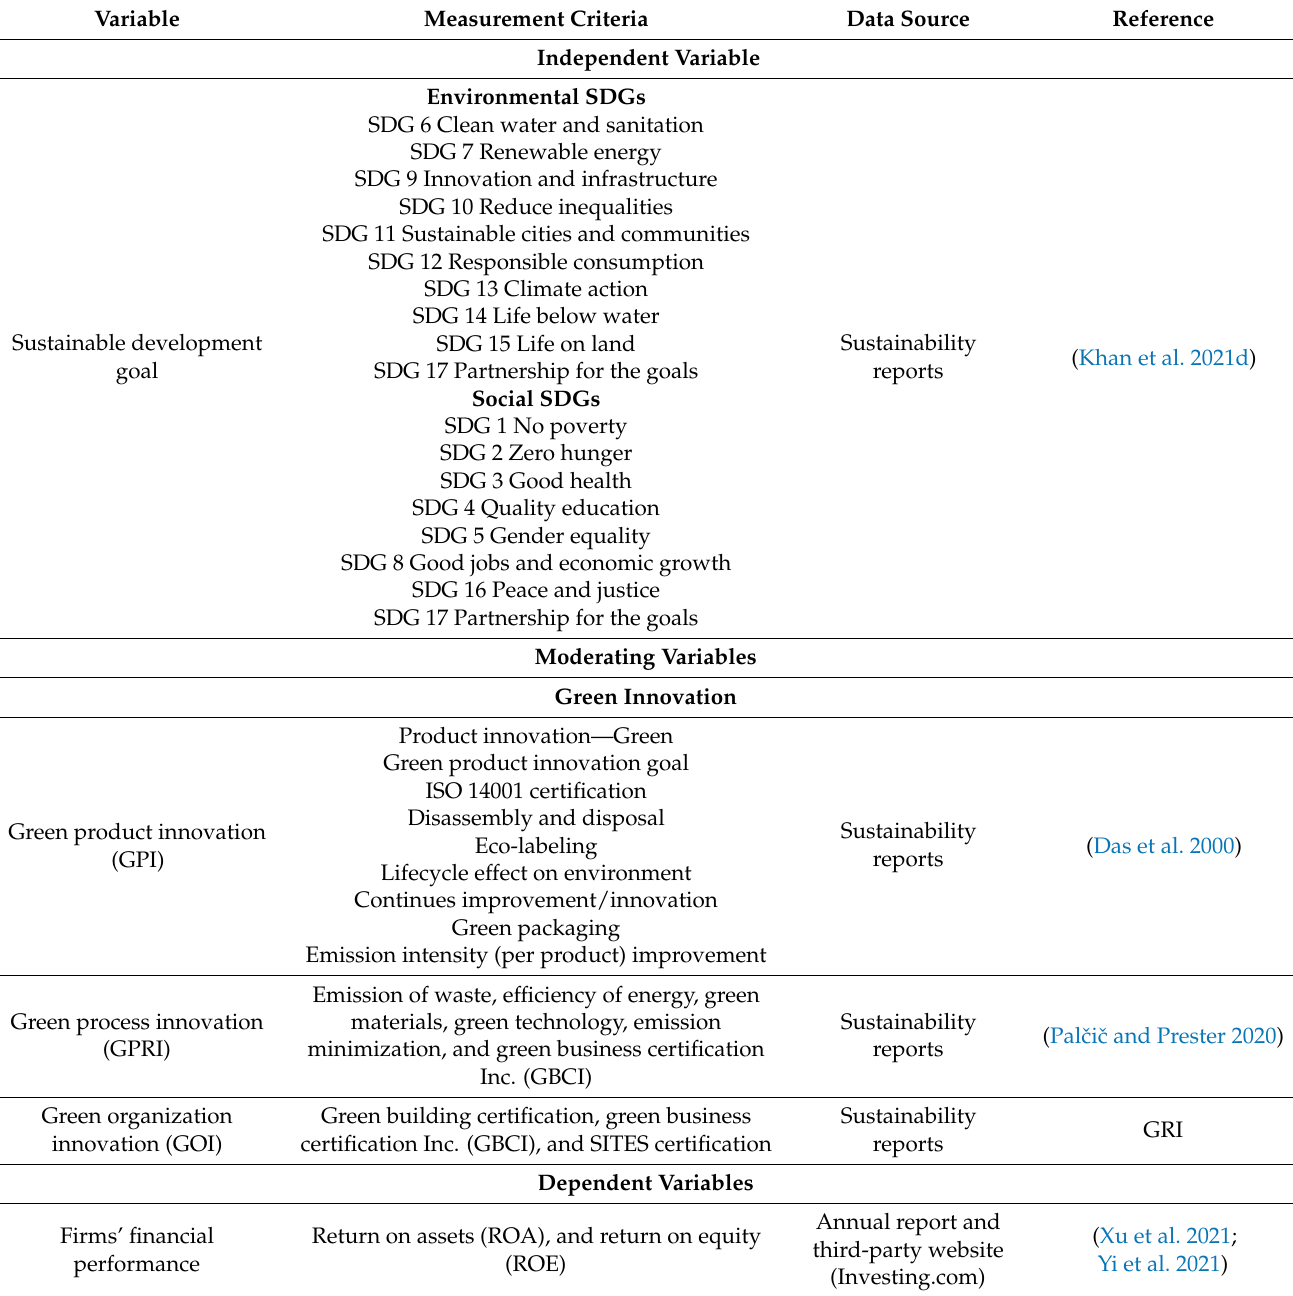
Table A1. Detailed Criteria in Selection Variable